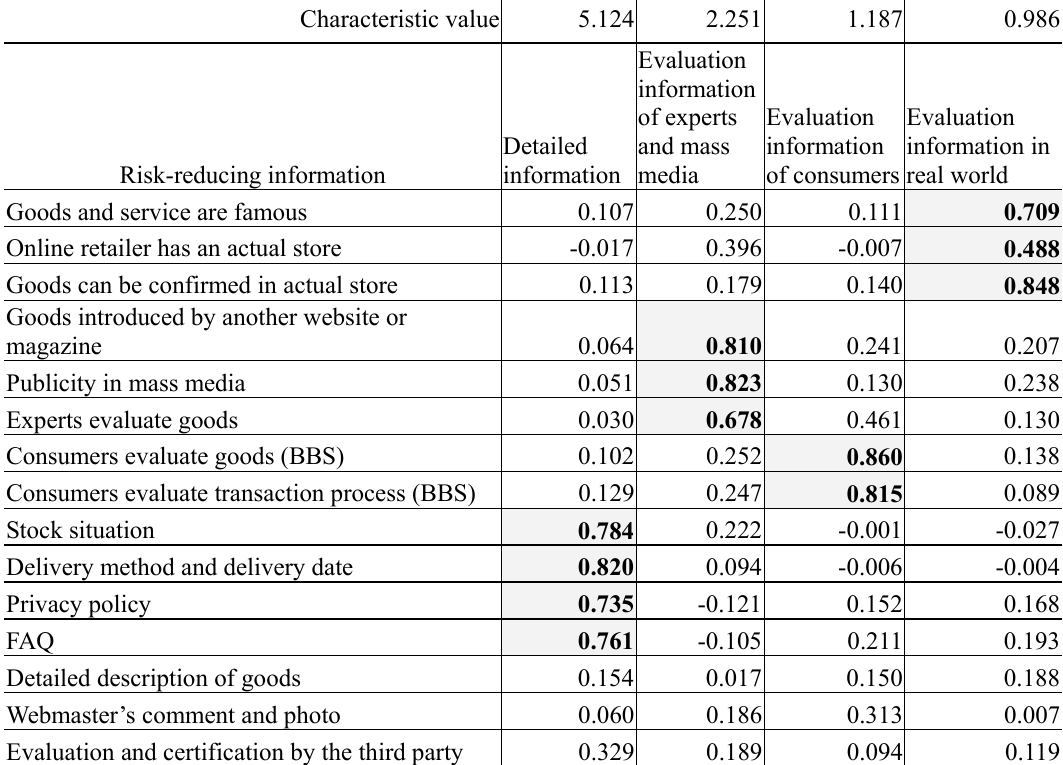
Table 2. Classification of Risk-reducing